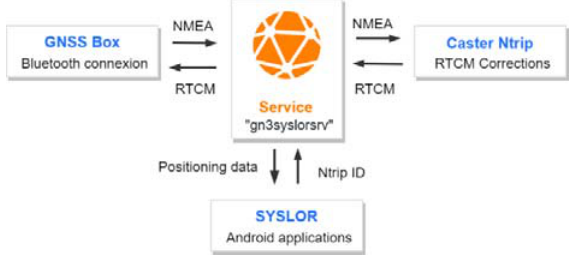
Figure 8 : Operation of the GNSS service